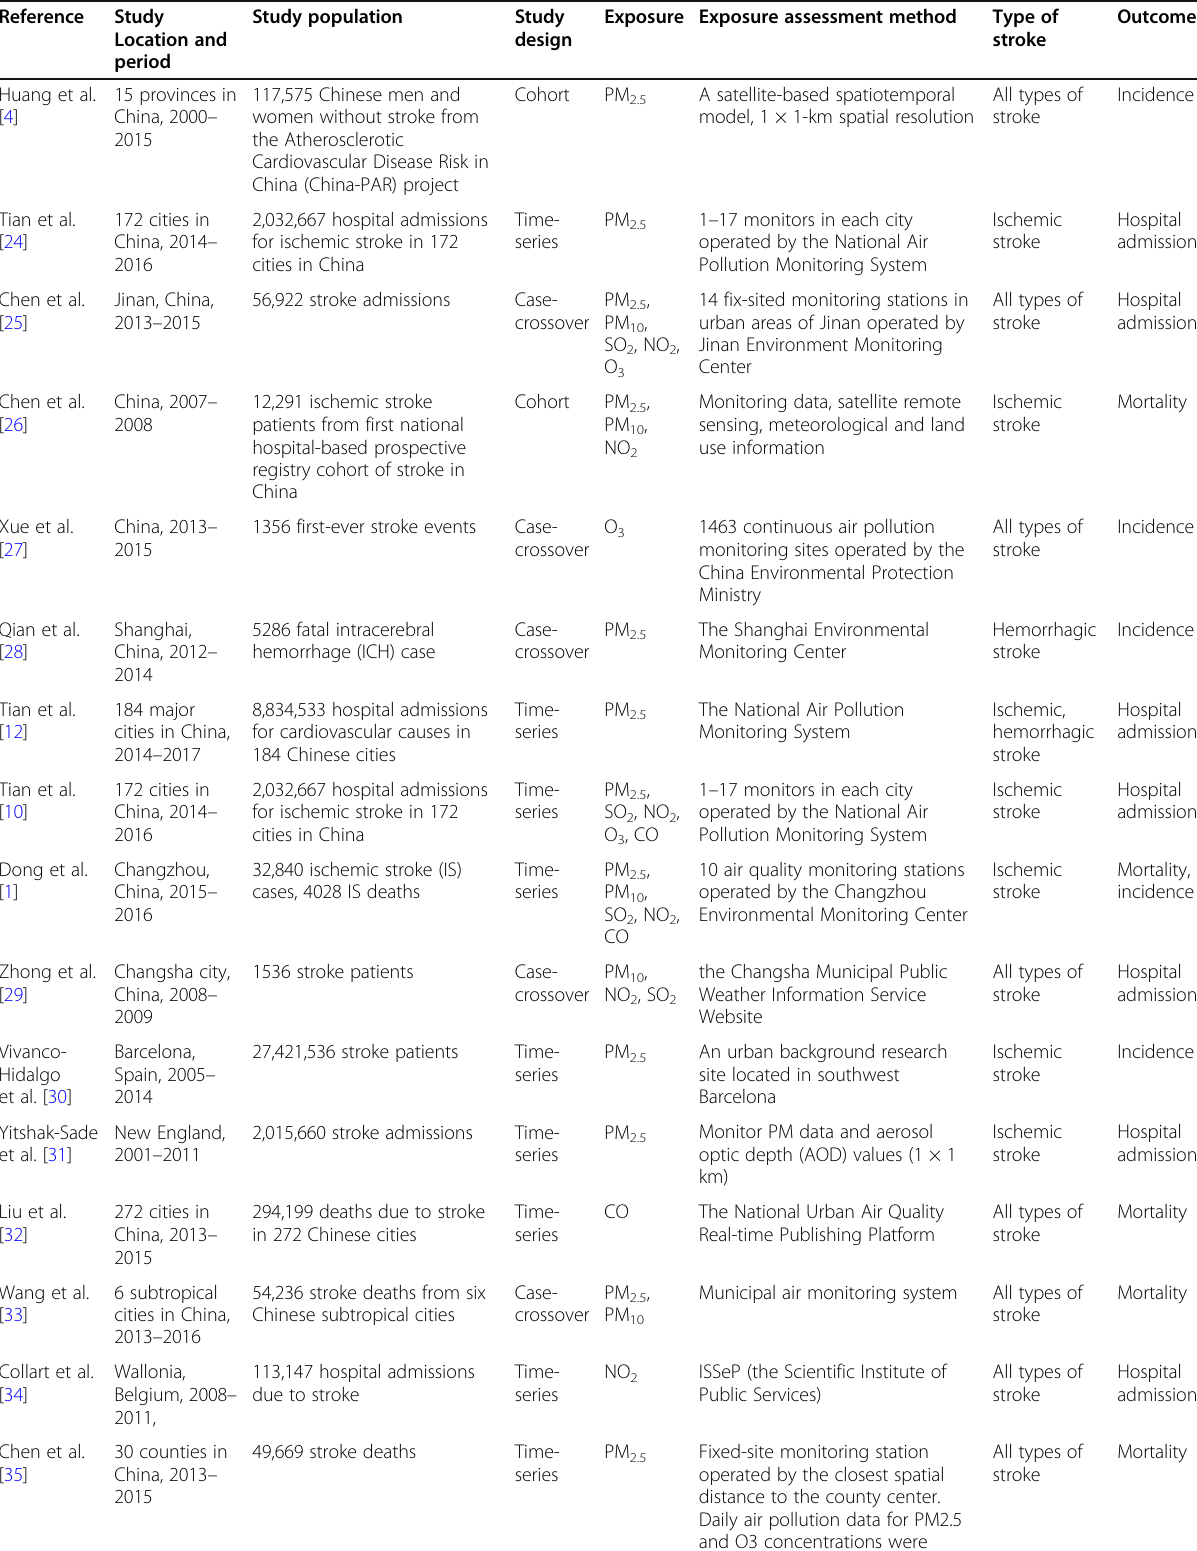
Table 1 Descriptive summaries for all included studies